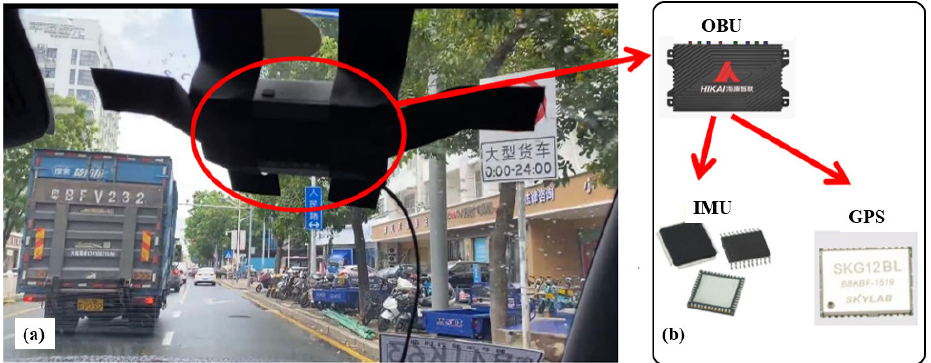
Figure 13. Experimental platform. ( a ) Installation of the equipment; ( b ) Detailed components of OBU.